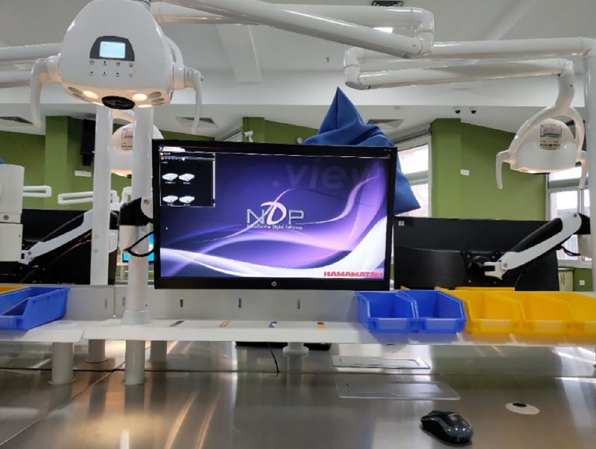
Figure 3. The homepage of NDP. View 2. Virtual slides can be selected and viewed by clicking on the folders in the upper left corner.